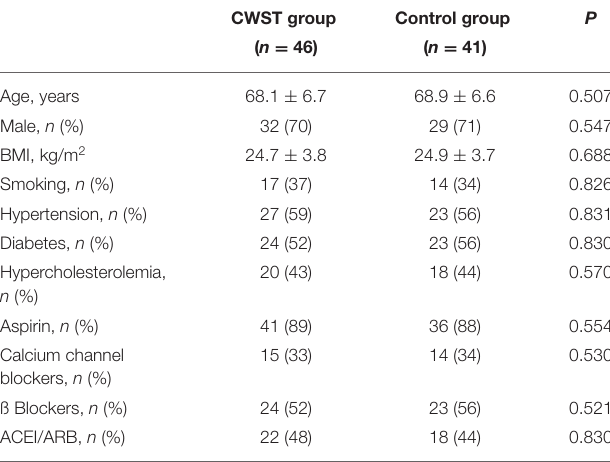
Data are shown as Mean ± standard deviation. CSWT, cardiac shock wave therapy; BMI, body mass index; ACEI, angiotensin converting enzyme inhibitor; ARB, angiotensin receptor blocker.